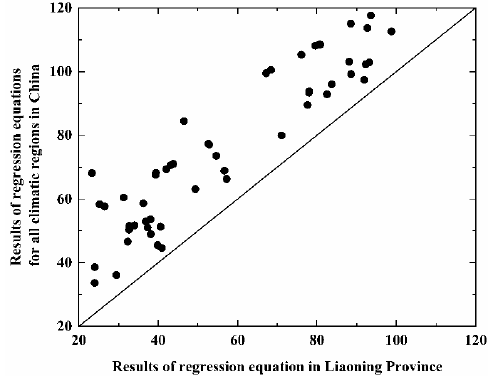
Figure 5. Comparison results of regression equations.